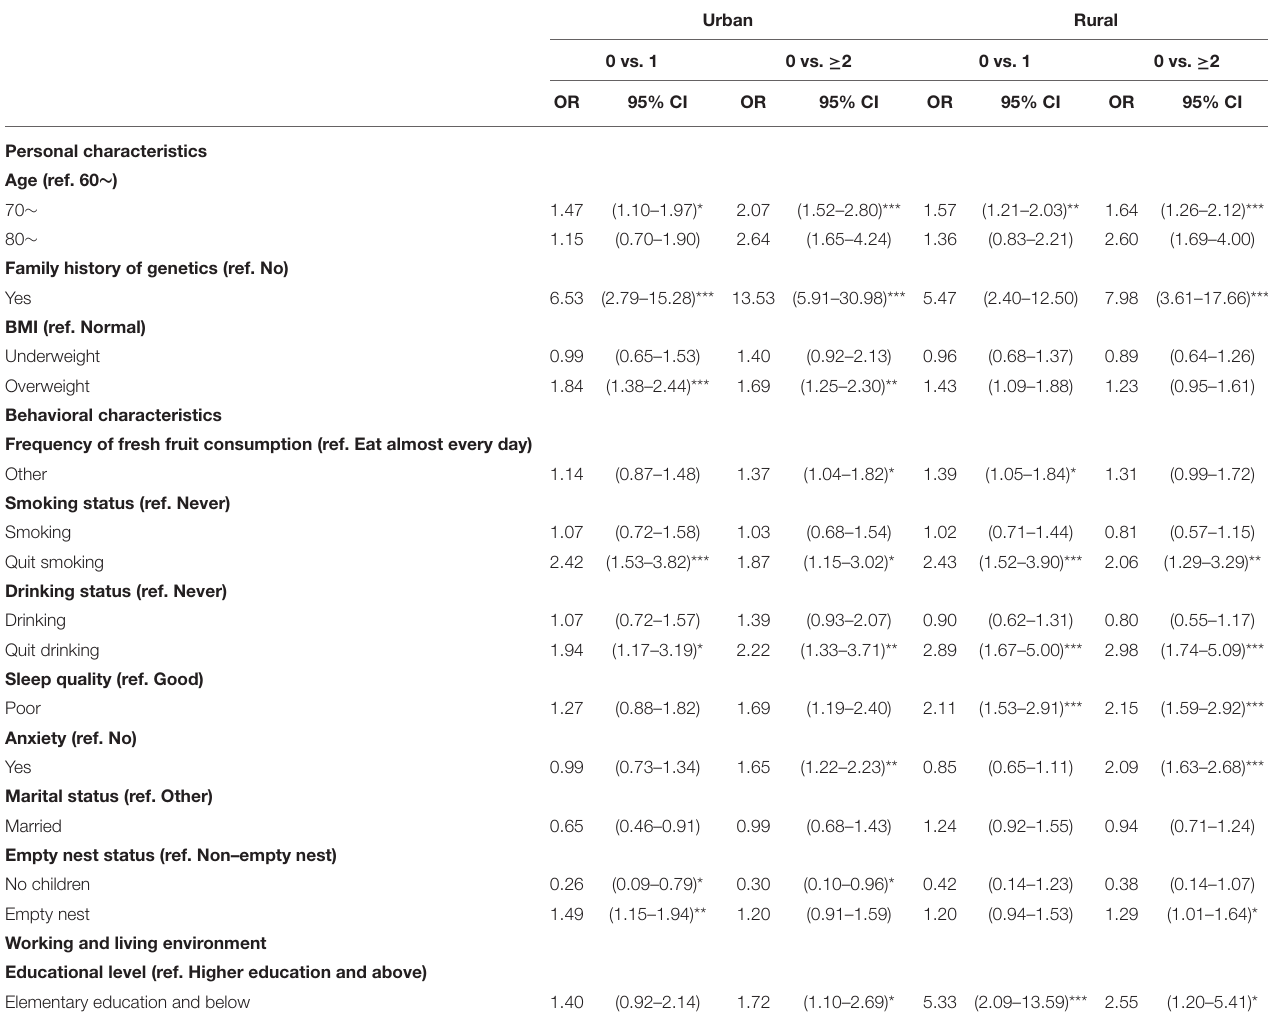
TABLE 5 | Multinomial logistic regression for having a single chronic disease and